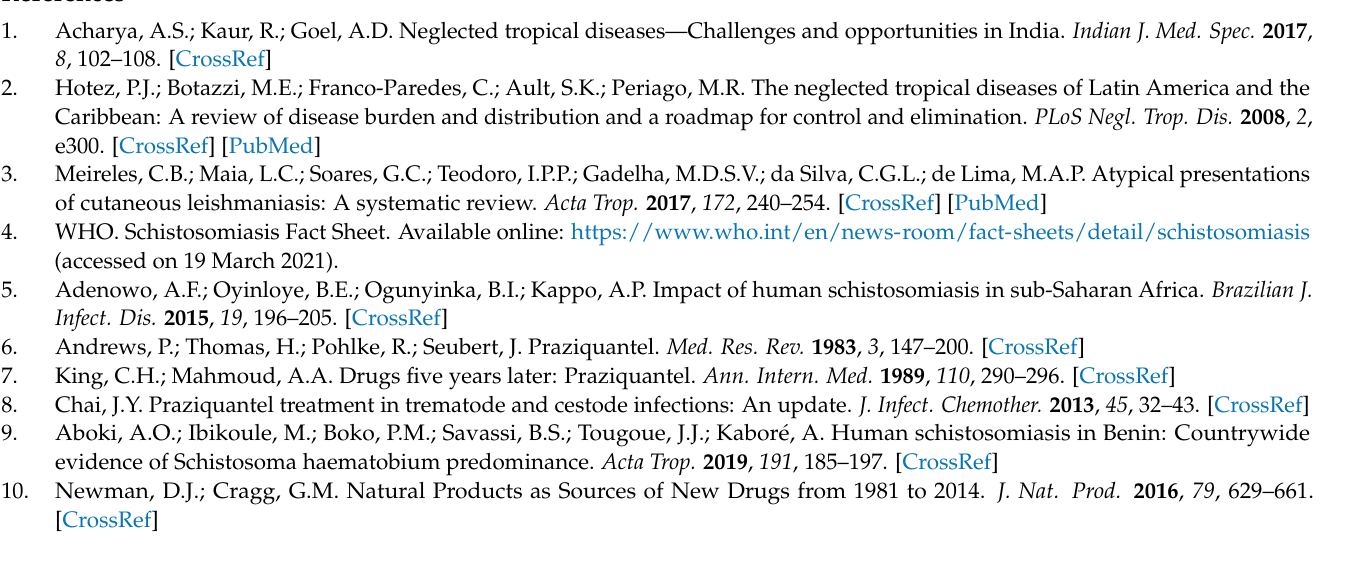
Figure A6. Molecular docking interactions between the five selected VS hits and the 6FTC protein. The light green represents the van der Waals interactions, the green represents the conventional H-bonds, the pink represents the pi-alkyl interactions, the purple represents the pi-sigma interactions, and the blue represents the water H-bonds.